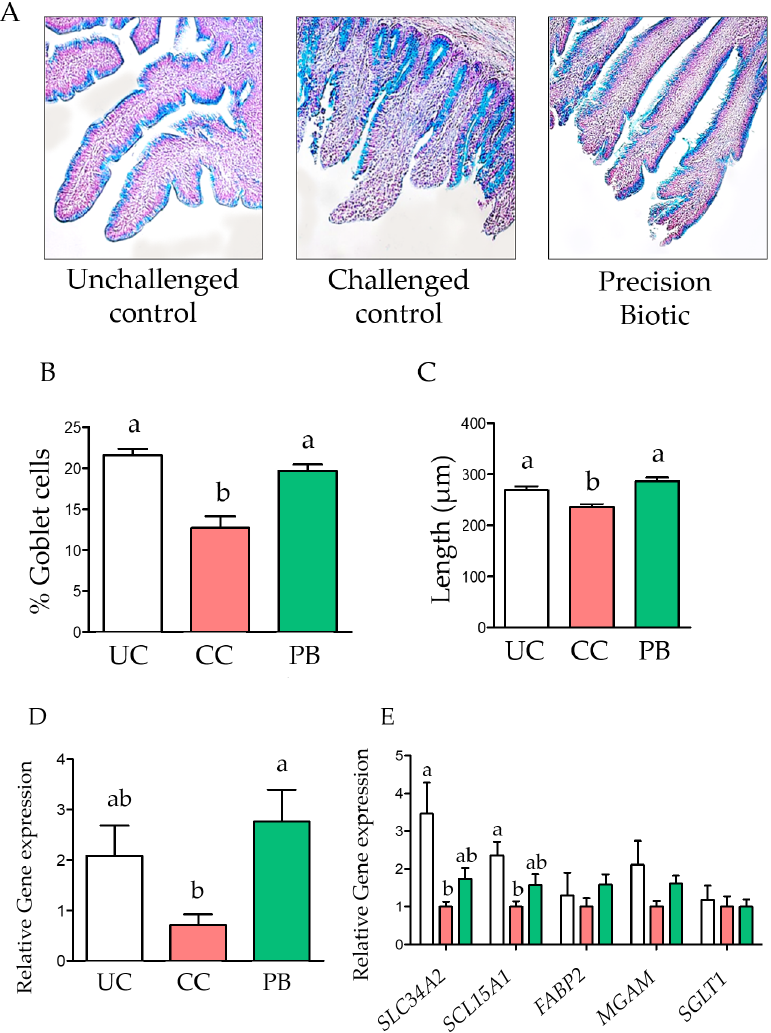
Figure 1. A precision biotic decreased damage in villi caused by an intestinal inflammation model at 21 days of age. ( A ) Representative histology slides of ileal mucosa (20× magnification). ( B ) Percentage of goblet cells, stained with Alcian Blue. ( C ) Mean villi length. ( D ) Relative gene expression of the sodium coupled monocarboxylate transporter 1 ( SLC5A8 ) in ileal mucosa. ( E ) Relative gene expression of the phosphorus transporter NaP IIb ( SLC34A2 ), the peptide transported PepT1 ( SCL15A1 ), the fatty acid binding protein 2 ( FABP2 ), maltase ( MAGM ), and the Na+-D-glucose cotransporter ( SGLT1 ) in ileal mucosa. One-way ANOVA with Tukey post-hoc test has been performed on all results; statistically significant differences ( p < 0.05) are indicated by different letters on the bars. UC: unchallenged control; CC: challenged control; PB: precision biotic.